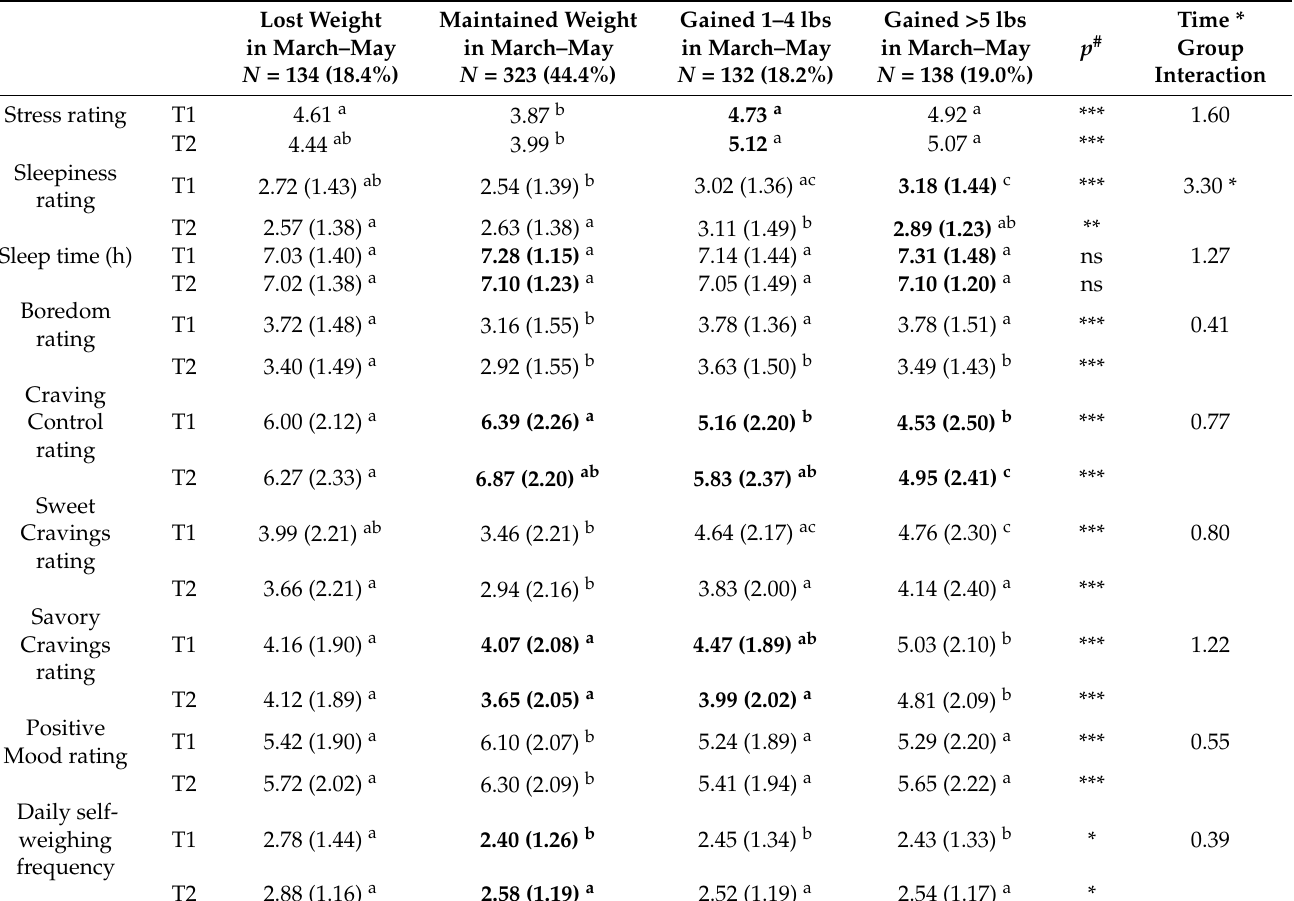
Table 3. Self-reported psychological state variables across weight risk groups during the peak lockdown (T1) and post the initial COVID-19 lockdown